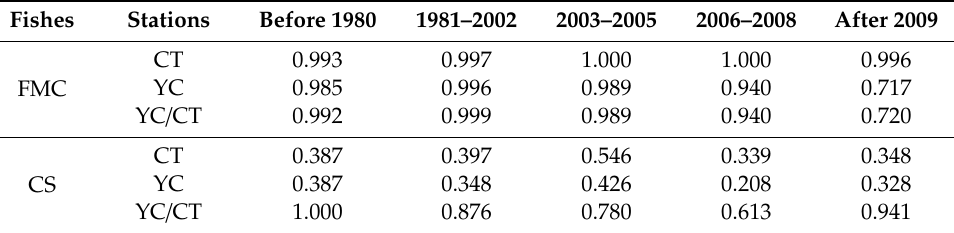
Table 4. Satisfying degree of SWT for the FMC and the CS during di ff erent stages. Fishes Stations